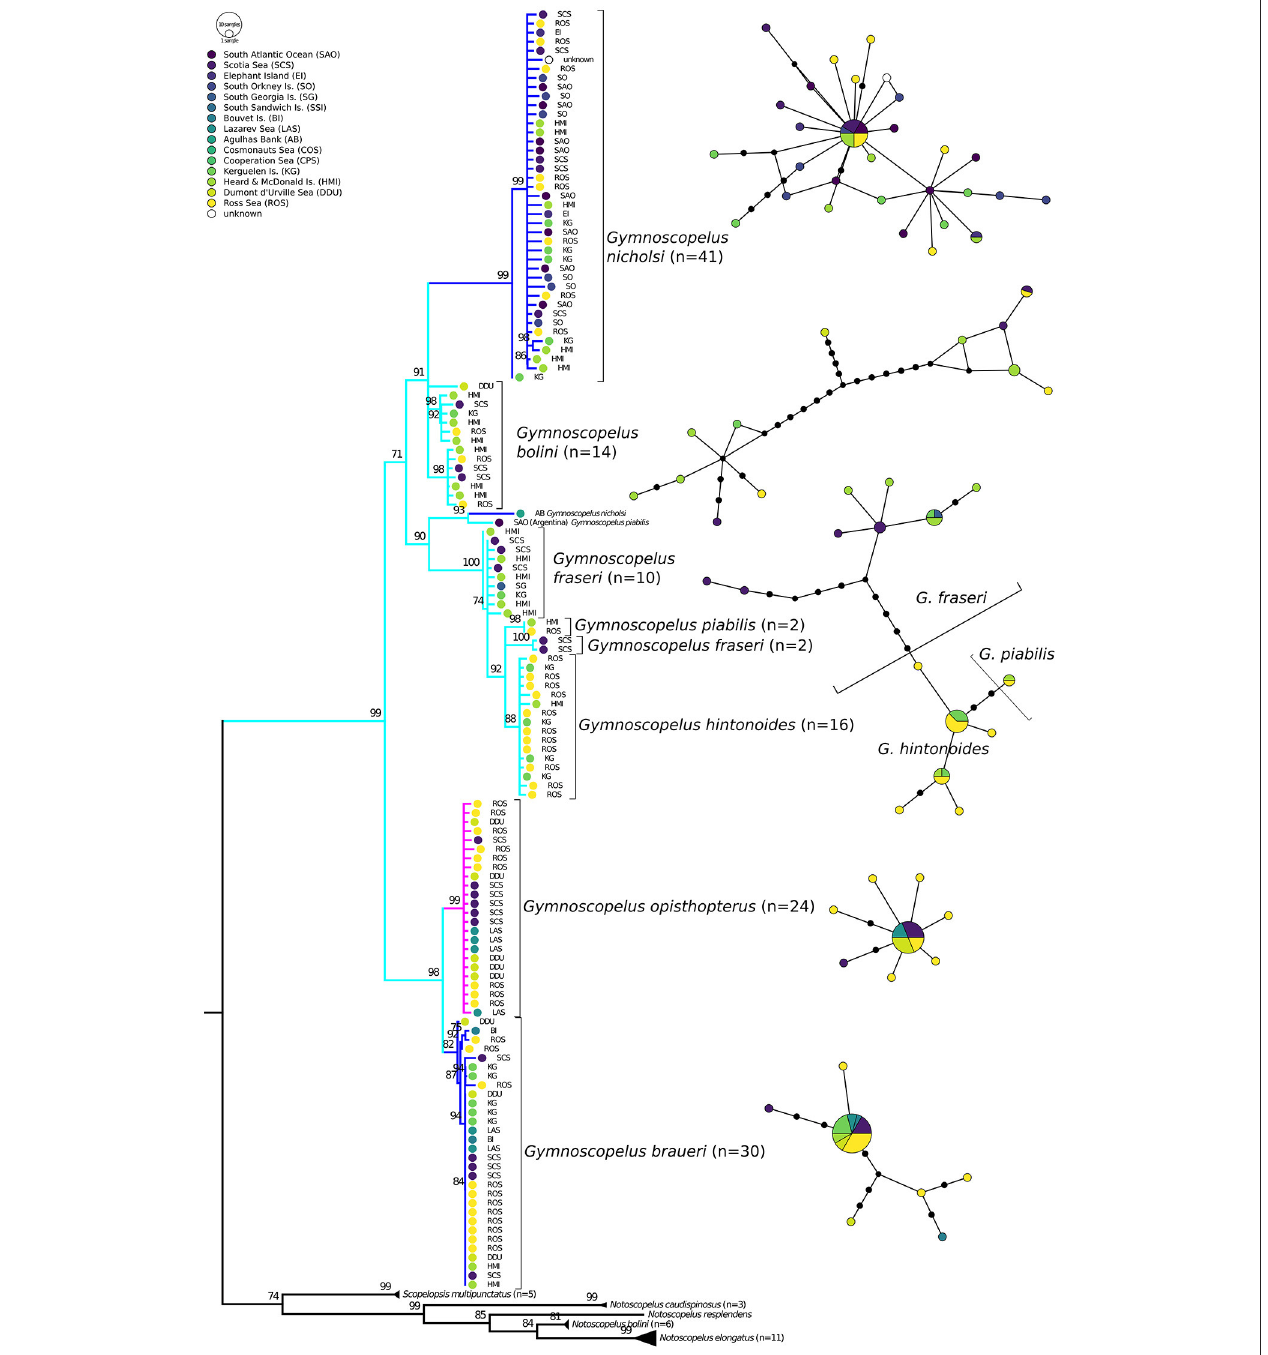
FIGURE 6 | Haplotype networks and phylogenetic consensus tree of myctophid fishes of the subfamily Gymnoscopelinae ( sensu Martin et al., 2017) based on cytochrome c oxidase I ( COI ) gene variation using a maximum likelihood analysis with 10,000 bootstrap permutations. Bootstrap support > 70 is shown above the branches; branches with lower support are collapsed to polytomies. Branches of species with Antarctic, broadly Antarctic, and sub-Antarctic distribution pattern following Duhamel et al. (2014) are depicted in purple, dark blue, and light blue, respectively (color figure available online). Geographic origin is reflected by colored circles in the tree and networks, approx. clockwise from West (dark) to East Antarctic (light). In the haplotype networks one branch represents one mutation. Additional mutation steps between samples are indicated with small black circles.